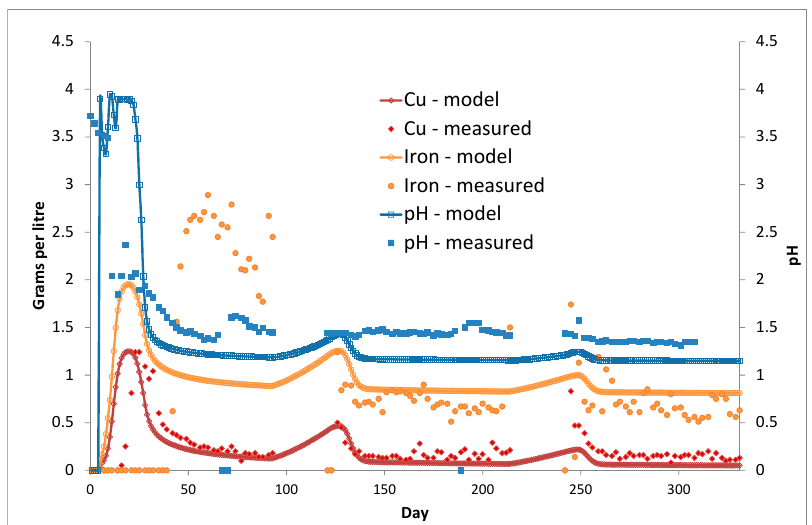
Figure 3. Concentrations in recovered solution.